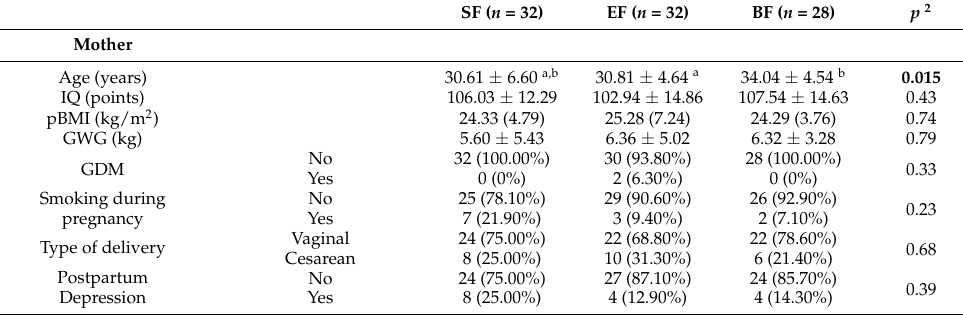
Table 1. Parents’ and neonatal baseline characteristics in study groups 1